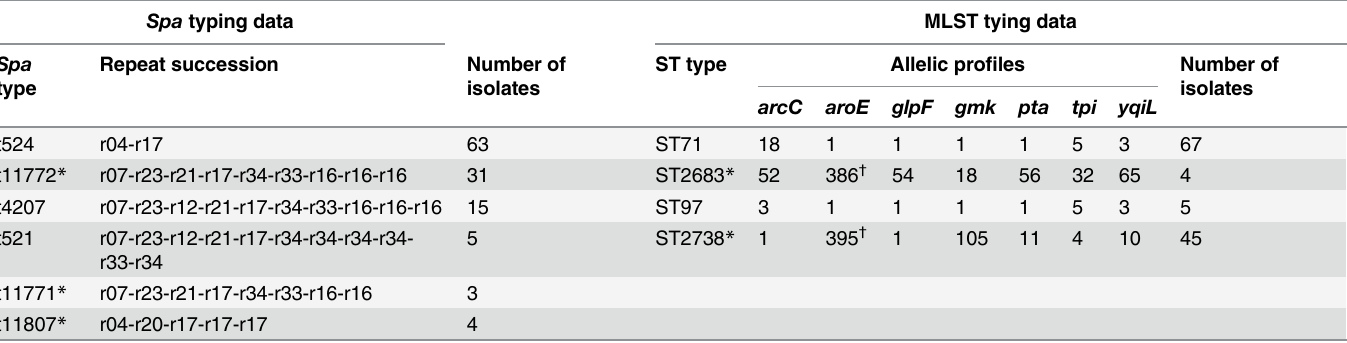
Table 1. spa and MLST types and allelic pro fi les of S . aureus isolates.